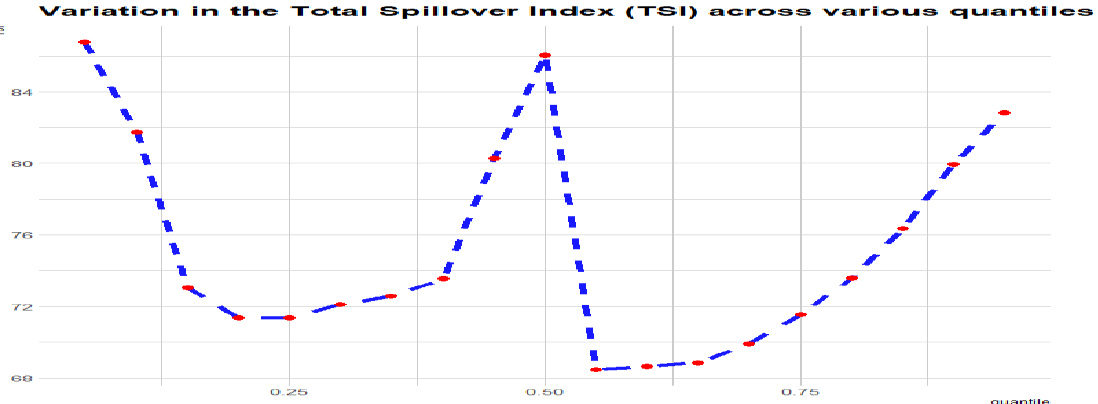
Figure 12. Total Spillover Index across different quantiles. Notes: Results are based on a 200-day rolling-window QVAR model with a lag length of order 1 (BIC) and a 20-step-ahead forecast.